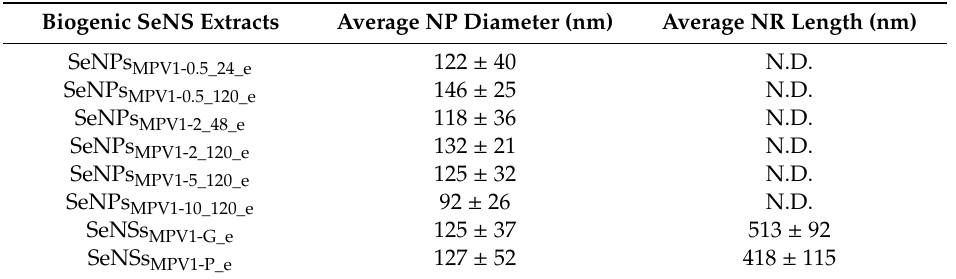
Table 3. Average diameter or length of SeNPs or SeNRs produced by MPV1 cells under different growth conditions.